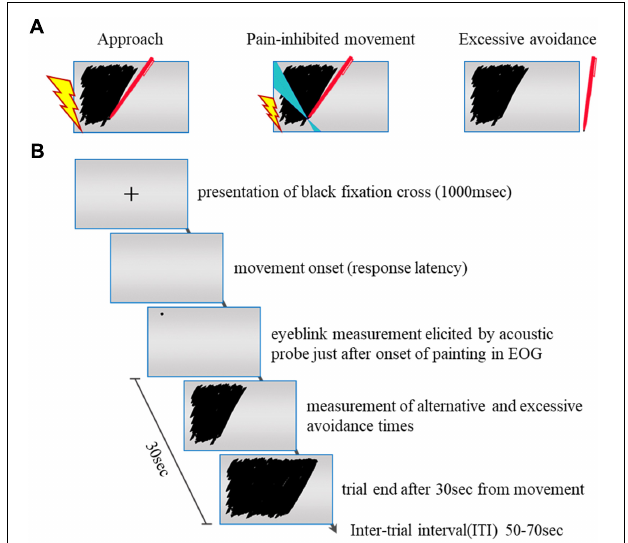
FIGURE 1 | (A) Pain stimulation condition. We examined each subject’s painting movement (approach) with an intense painful electrocutaneous stimulus and his or her specific movement (pain-inhibited movement) with a weak painful stimulus and whether and at what time point the subject stopped painting (excessive avoidance) with no painful stimulus. The lightning bolt represents the presentation of the pain stimulus. Blue areas in condition B represent the specific directions (120–140 ◦ ). (B) Flowchart of the experimental task. +: The fixation cross serving as the starting signal. The disappearance of the fixation cross is the movement onset. The subject could freely choose the three conditions in each trial: painting with intense pain stimulus, specific movement with weak pain stimulus, or stopping painting with no pain